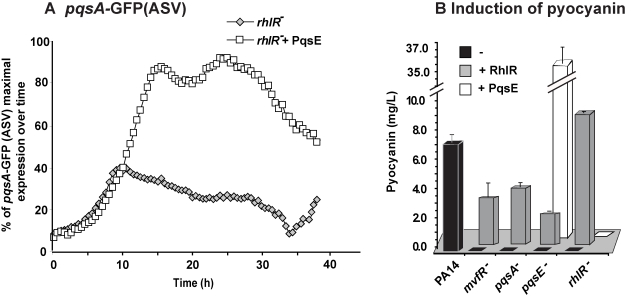
MvfR network regulation requires finely tuned cooperation between the MvfR component PqsE and the AHL QS regulator RhlR.(A) The expression of pqsA was determined by measuring GFP emission. A pqsA-GFP (ASV) fusion in the rhlR mutant harboring pDN19pqsE was used to determine pqsA expression levels. (B) Pyocyanin levels were measured from various PA14 mutants harboring either pDN19pqsE or pUCP20rhlR plasmids. Empty vector served as control.